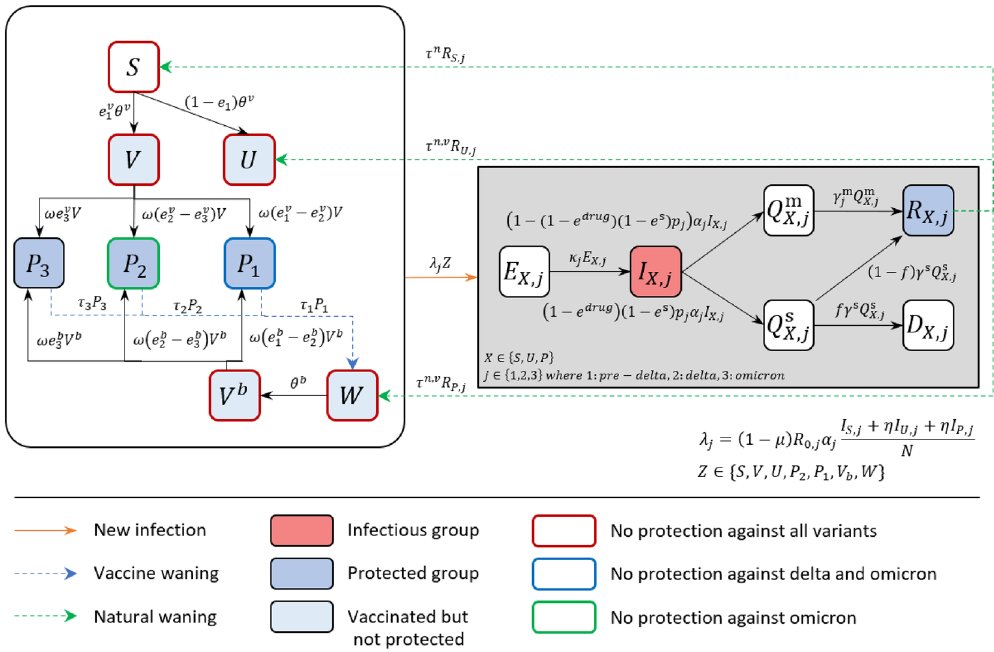
Figure 7. The model flowchart depicts the transmission of COVID-19 considering different variants, vaccinations, waning, and booster shots. The large round box group the compartments of non-infected people with different vaccine statuses. The compartments enclosed by red, green, and blue round boxes indicate individuals who can be infected by any variant, only Delta and Omicron, and only Omicron, respectively. The P j compartments represent the vaccinated individuals who are protected from the variants. The compartments inside the gray box denote infected individuals who are in one of several stages of infection, such as latent, infectious, isolated, recovered, or deceased.